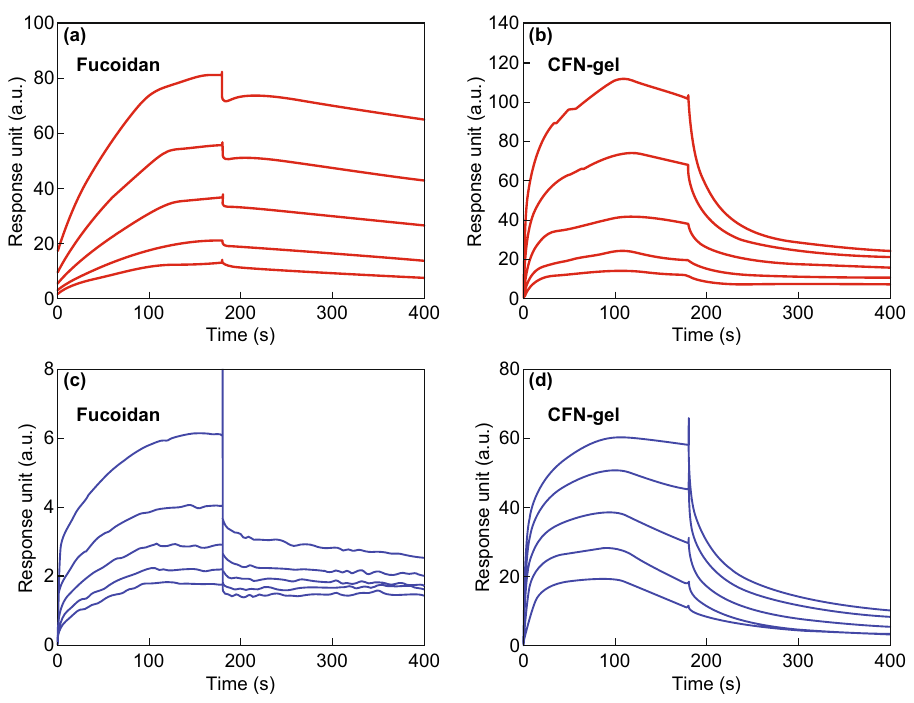
Fig. 4 Surface plasmon resonance (SPR) analysis. a Sensorgram of SPR for evaluating the binding affinity between fucoidan and VEGF 165 (equilibrium dissociation rate constant ( K D ) = 953.0 nM) and CFN‑gel and VEGF 165 ( K D = 756.1 nM), b sensorgram of SPR for evaluating the binding affinity between fucoidan and P‑selectin ( K D = 69.71 nM), and between CFN‑gel and P‑selectin ( K D = 718.9